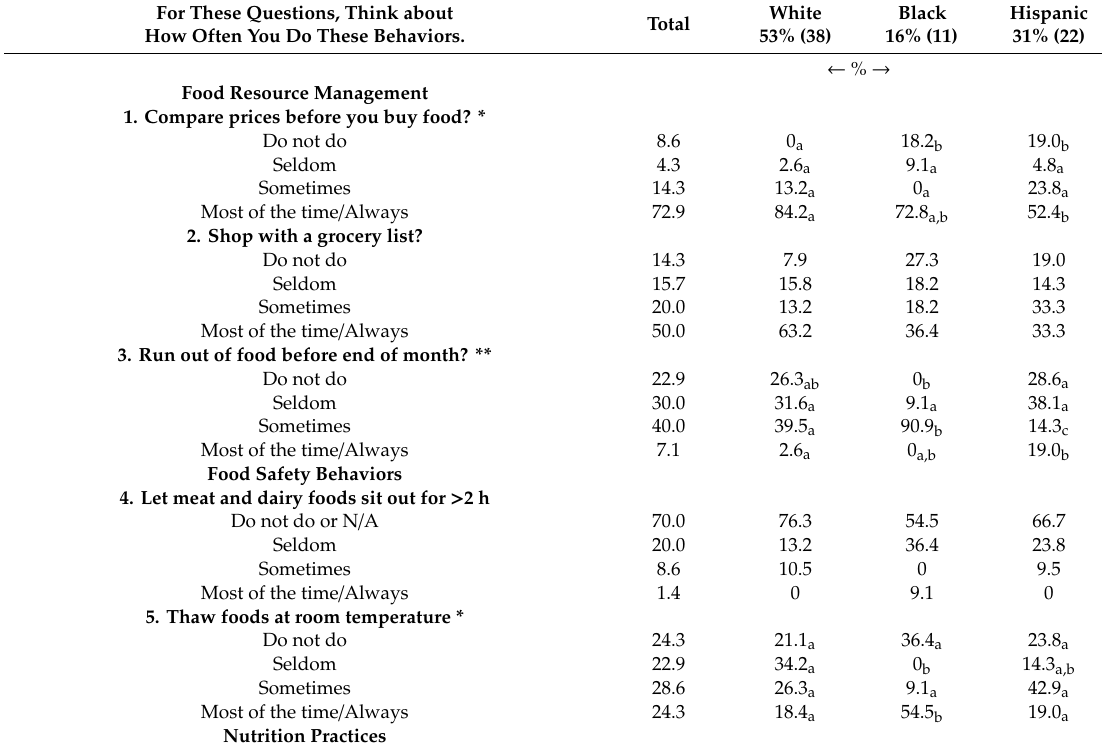
Table 2. Food behavior checklist (FBC) questionnaire responses among Arizona men utilizing assistance programs by race / ethnicity category (%; N =